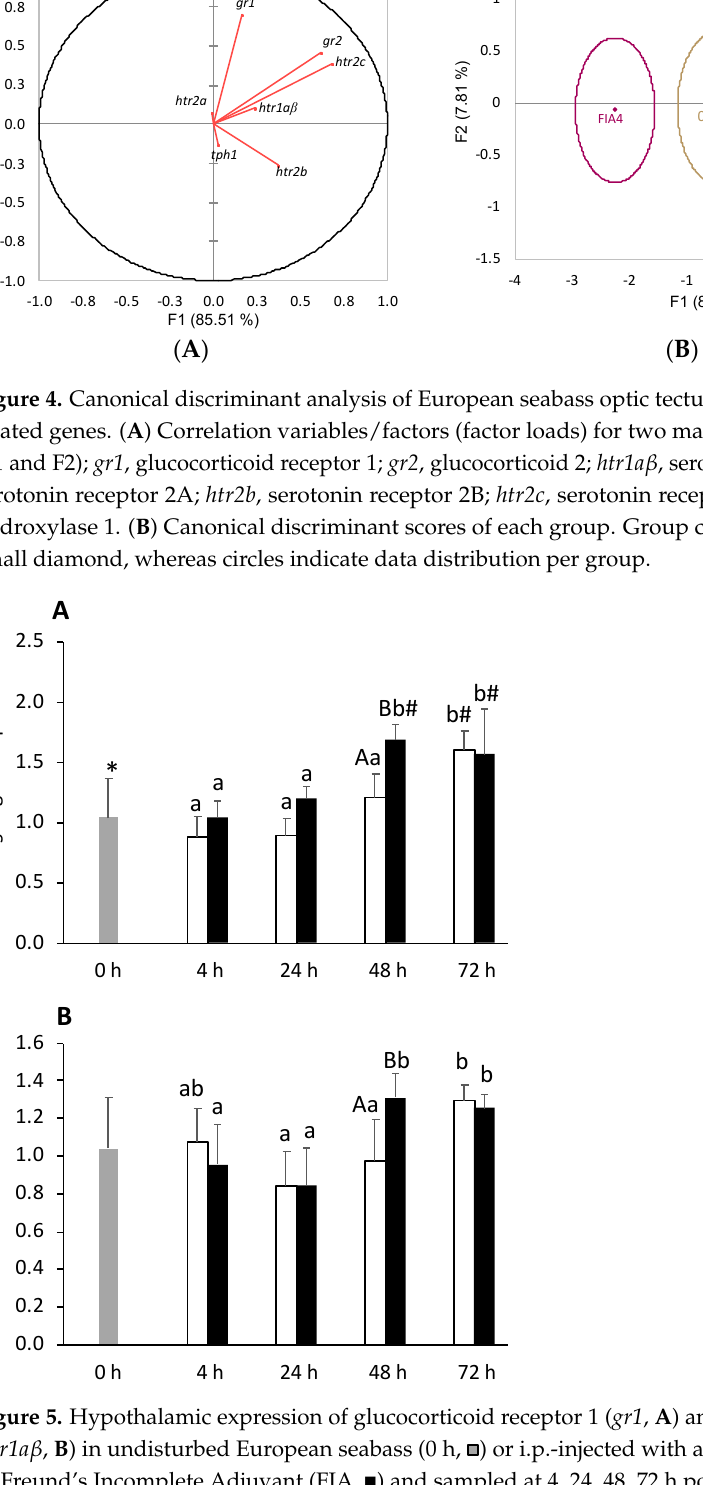
marked by a small diamond, whereas circles indicate data distribution per group.